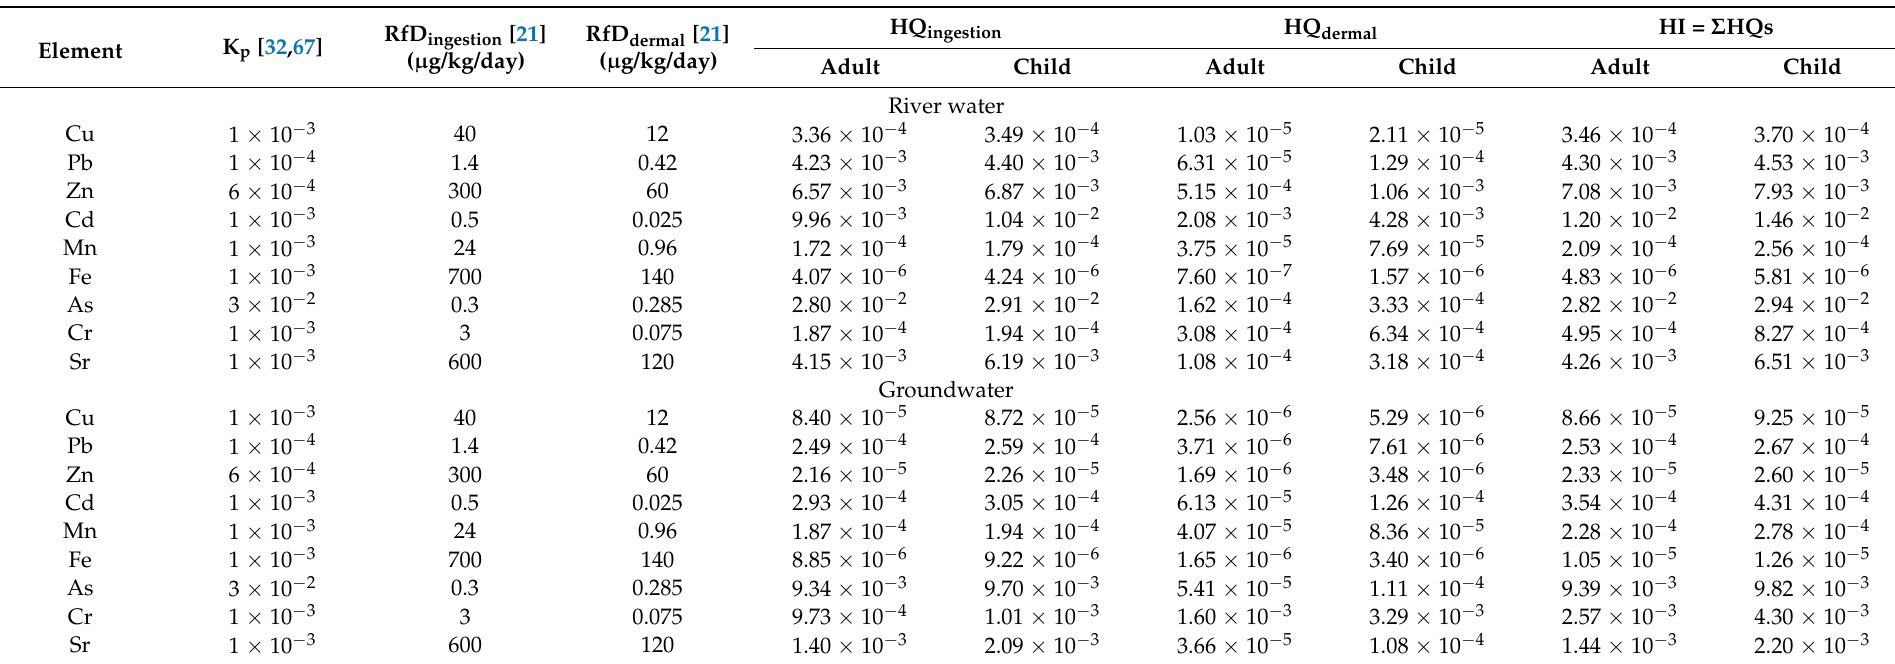
Table 6. Reference dose (RfD), hazard quotient (HQ), and hazard index (HI) for each element in river water and groundwater in the Sidi River’s karst